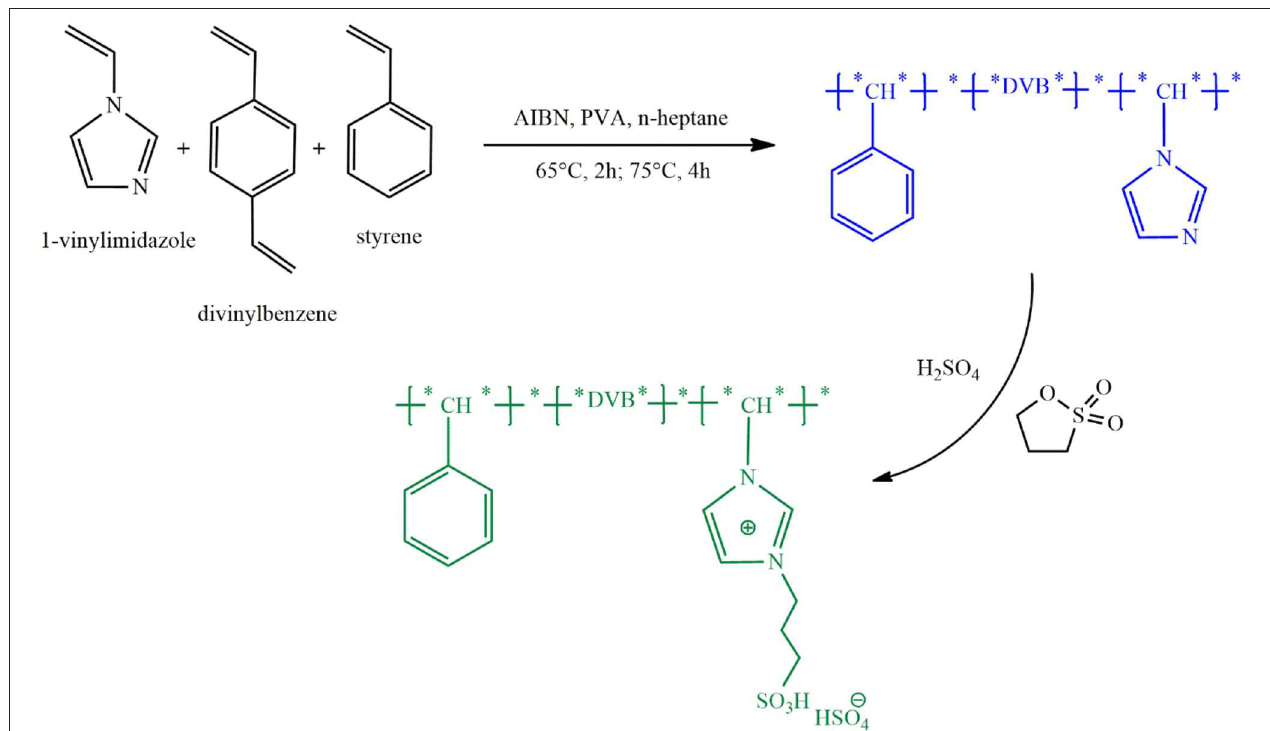
FIGURE 4 | Fabrication procedure of P(VB-VS)HSO 4 [Redrawn with modification from Feng et al.